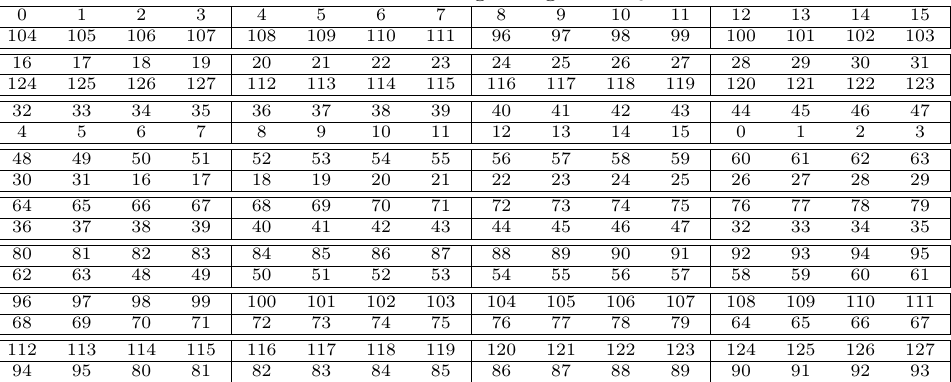
Table 9: Permutation to get original K 28 from K